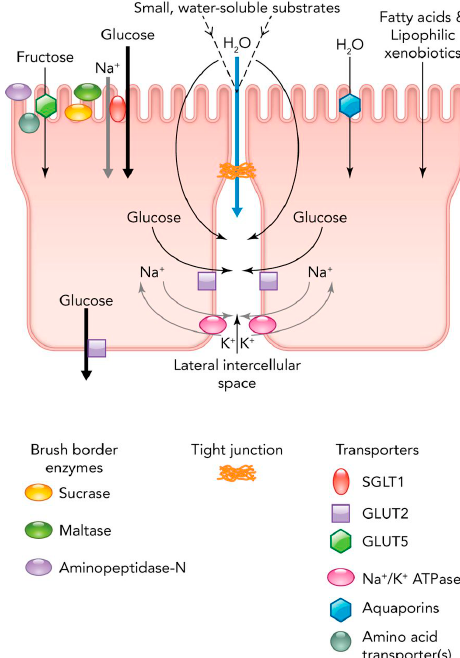
Figure 1. A model of the principal mechanisms by which nutrients are absorbed across the avian and chiropteran intestinal border. While both fructose and glucose are absorbed at high rates across the brush border via carrier-mediated pathways, as occurs in humans and other terrestrial mammals, substantial flux occurs via paracellular (diffusion or solvent drag) pathways in flying vertebrates [1]. Among small nectarivore species, like hummingbirds and nectar bats, brush border enzyme and glucose transporter (GLUT) and Na + -dependent glucose transporter (SGLT)-mediated transport activity per unit of intestinal area is high. However, paracellular absorption must also occur at especially high rates in the intestines of these nectarivores in order to satisfy overall energy budget (and thus absorptive) demands. Figure reprinted with permission from Price et al.